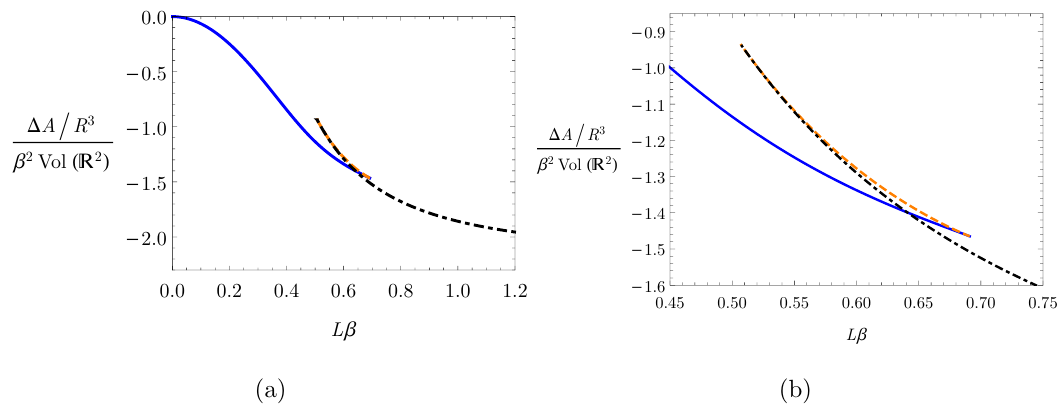
Figure 4. For the g ( z ) in eq. (3.9c), and for the strip, (a) shows the di(cid:11)erences in area, (cid:1) A , (cid:0) R 2 (cid:1) normalized by (cid:12) 2 Vol =R 3 , between three extremal surfaces in the bulk (blue solid, orange dashed, black dot-dashed) and the minimal surface in AdS 5 with the same L , indicating a \(cid:12)rst- order phase transition" at L(cid:12) (cid:25) 0 : 65 from one (blue solid) to the other (black dot-dashed) as the area functional’s global minimum. (b) Close-up of (a).